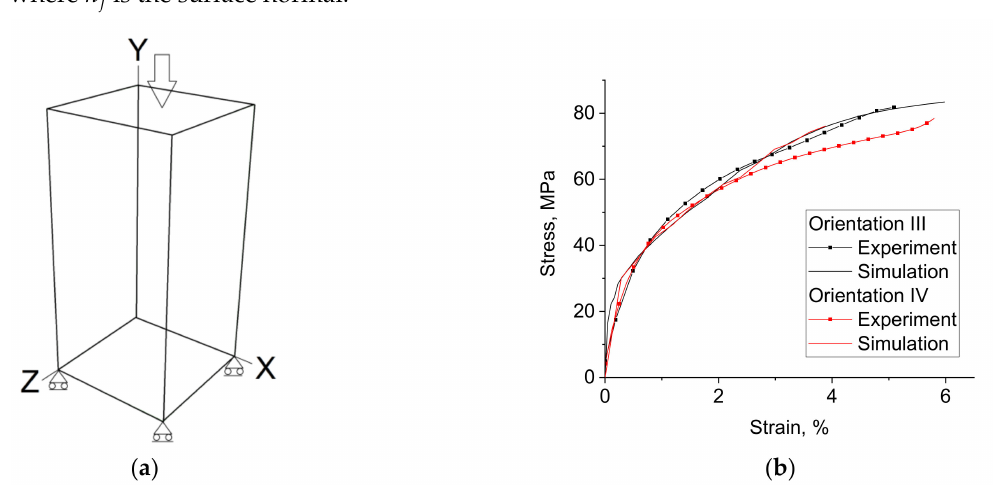
Figure 3. Schematic of a FE model with the applied boundary conditions ( a ) and stress–strain curves for single crystals with lateral faces compressed along [110] direction ( b